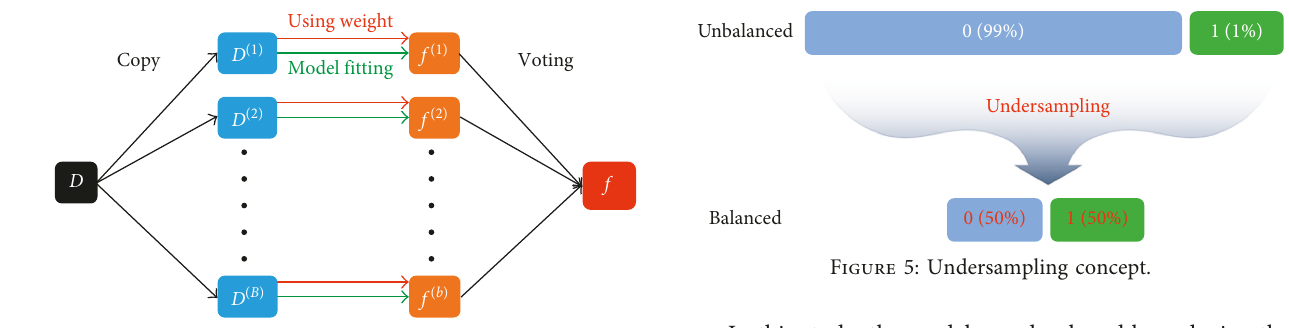
Figure 4: Boosting concept.